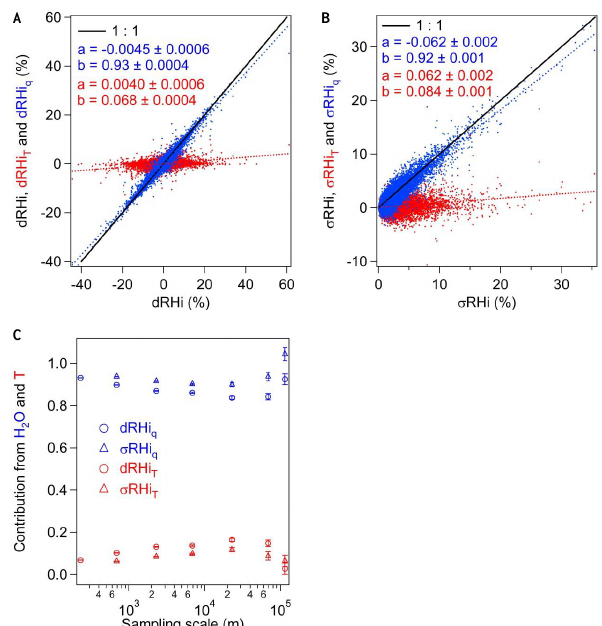
Fig. 11. Contributions to RHi horizontal variability from H 2 O and T horizontal variabilities. The horizontal variability ( dP <1hPa) of all RHi at T ≤− 40 ◦ C is analyzed, including both ISS and non- ISS conditions. Intercept and slope of the linear fits (H 2 O: blue dots; T : red dots) are represented by value a and b in the legend, respectively. (A) 1Hz d RHi for all RHi (sample size N =288827); (B) 1Hz σ RHi at ∼ 2.3km (10s) scale for all RHi ( N =57196); (C) scaling of H 2 O and T contributions from ∼ 230m to 115km (500s). Sample sizes of d RHi from ∼ 230m to 115km are 288827, 85875, 20526, 6189, 1579, 372 and 166, respectively. Sample sizes of σ RHi from ∼ 690m to 115km are 192499, 57196, 18601, 5186, 1476, 768 and 303,